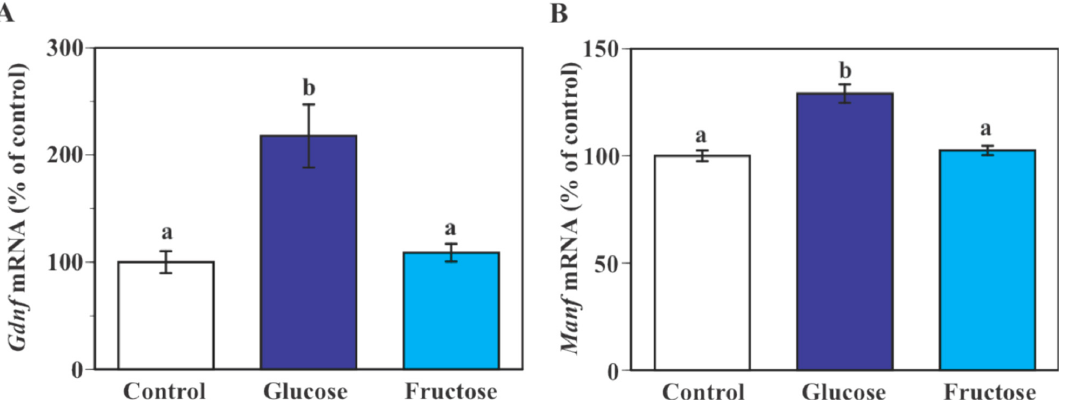
Figure 4. Effect of fructose on the expression of Gdnf and Manf mRNA in microglial SIM ‐ A9 cells. Cells were incubated in a culture medium containing either 17.5 mM glucose (control), 25 mM glucose (glucose) or 17.5 mM glucose + 7.5 mM fructose (fructose) for 24 h. Levels of Gdnf ( A ) and Manf ( B ) mRNA were measured by real-time PCR. Values in the control group were set to 100%. Data are means ± S.E.M. ( n = 7–14/group). Groups that do not share a common letter are statistically different ( p < 0.05 by Tukey–Kramer